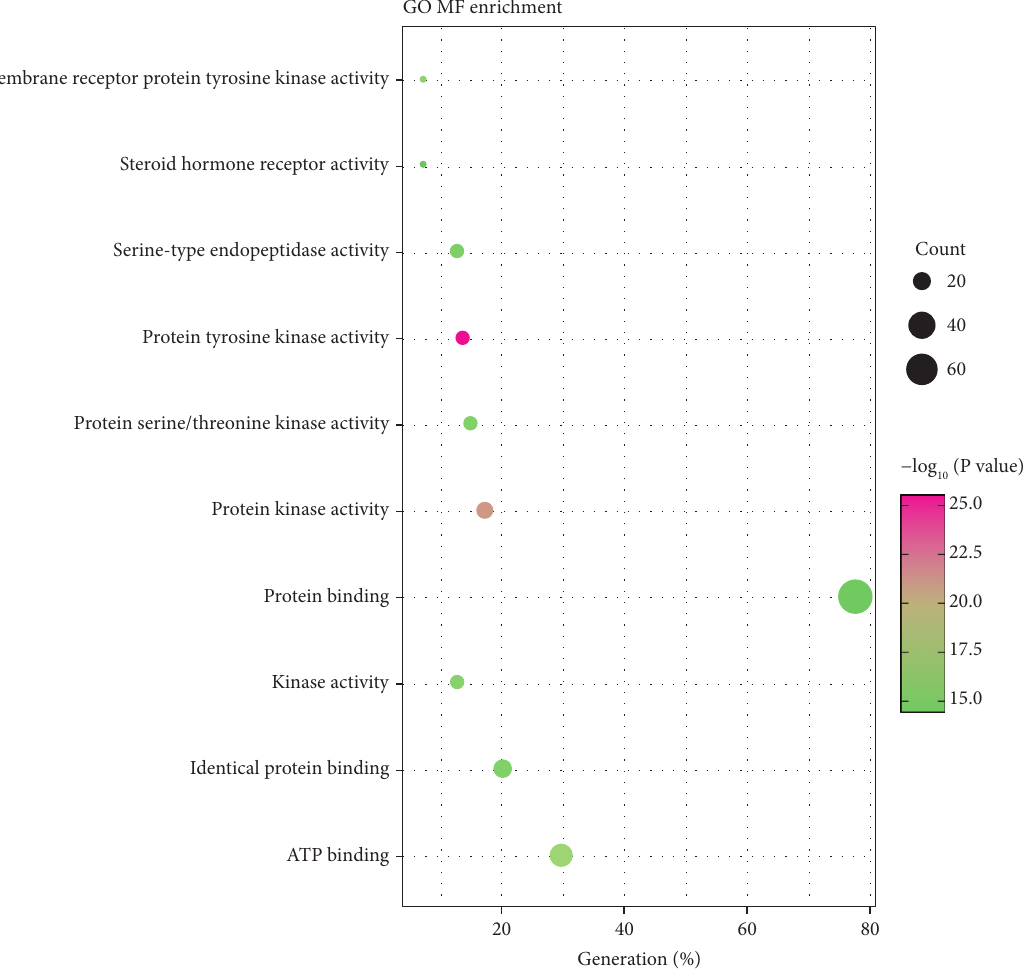
Figure 7: MF in GO enrichment